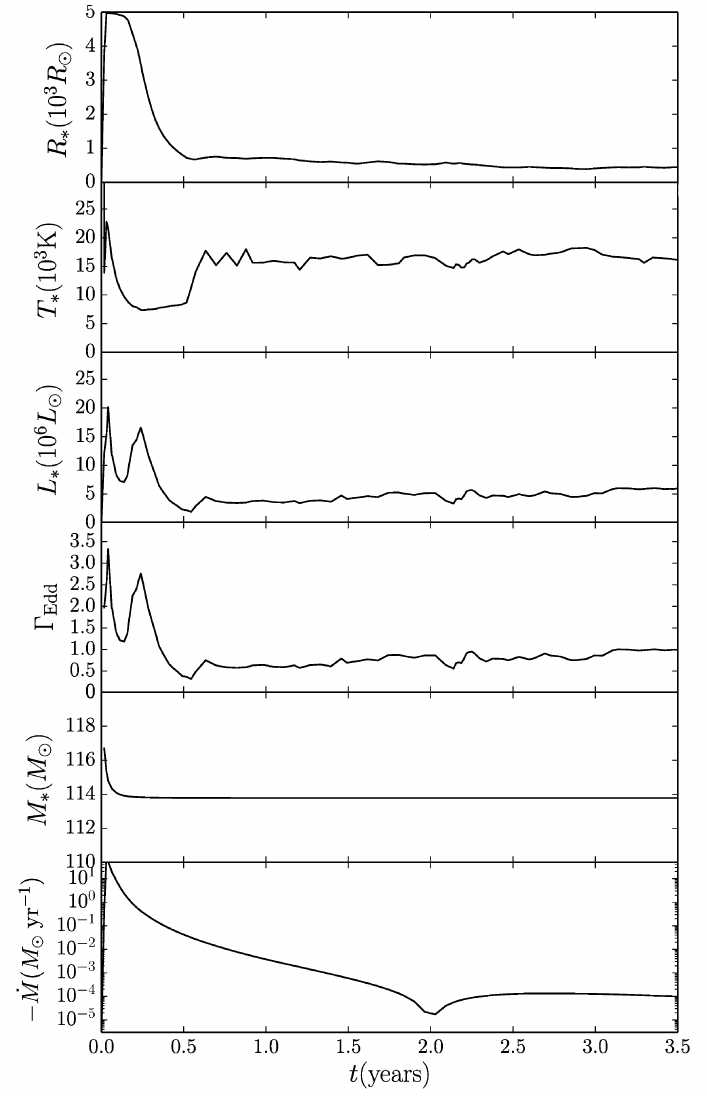
Figure 3. Results of one of our 3D simulations showing the recovery of a non-rotating VMS of 120 M (cid:12) after removing an outer layer of 6 M (cid:12) according to approach 2 (as a result of extracting energy from the core). From top to bottom, the panels show the stellar radius, effective temperature, luminosity, mass, Eddington ratio, and mass-loss rate. The temperature, radius, and luminosity were calculated at an optical depth of τ = 3. This figure can be compared to the right panel of Figure 3 in [36] which shows the equivalent 1D simulation. In this 3D simulation, the first few years after the eruption bring the star to an almost stable hydrostatic equilibrium. The mass-loss rate is roughly two orders of magnitude smaller than that in the 1D simulation. Although the results of this preliminary work are still under study, they are probably due to the lower coherency of the pulsations in the 3D, compared to the 1D, simulation. The three spatial degrees of freedom engender destructive interference of the pulsations that damp the waves before they reach the surface and eject